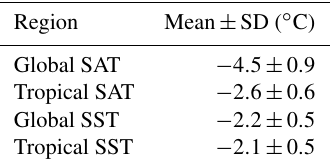
Table 2. Summary of temperature reconstruction. Area-weighted average of reconstruction of SAT and SST, global and tropical (30 ◦ S–30 ◦ N)